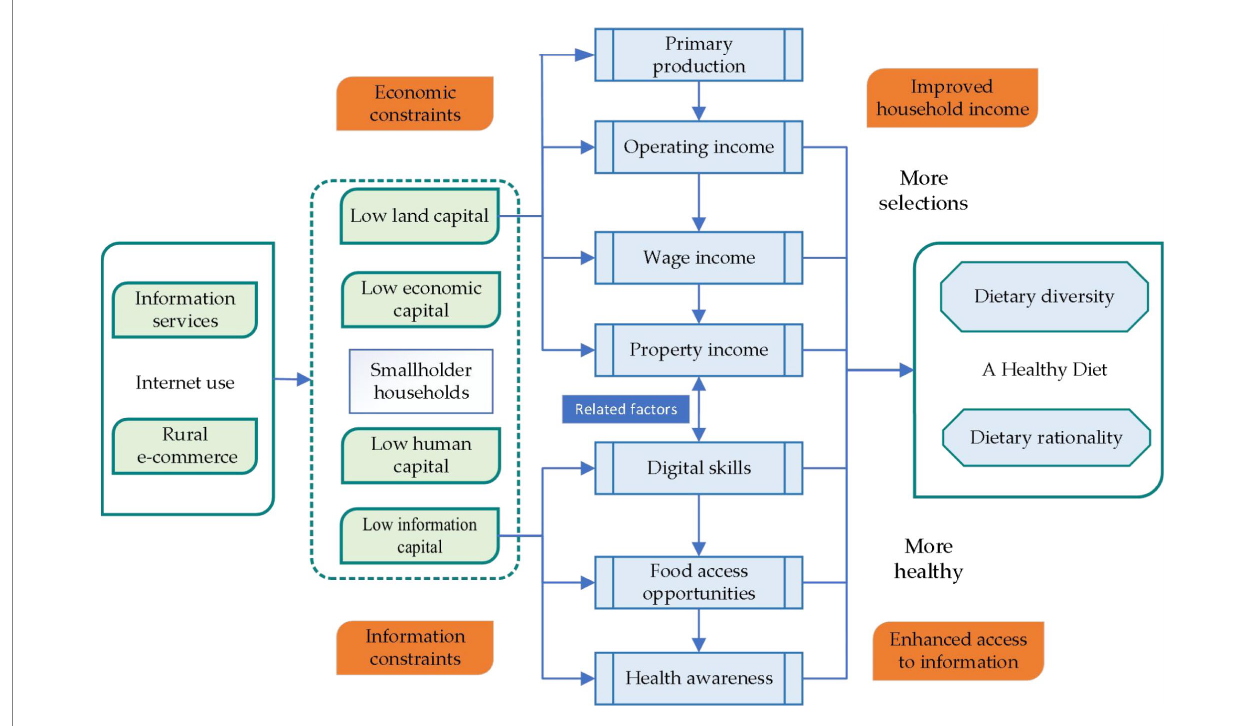
FIGURE 1 A theoretical model of the impact of Internet use on smallholder household